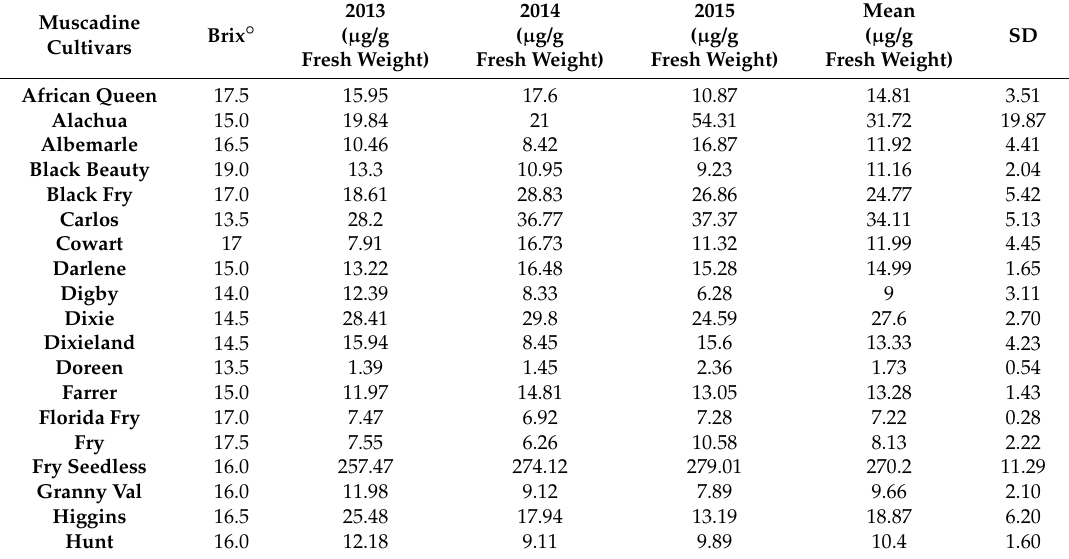
Table 2. Total stilbenoids content of 42 muscadine cultivars for year (2013, 2014, and 2015). Concentration levels reported ( µ g/g fresh weight of the whole berry) are average values for the total stilbenoids content obtained from three biological